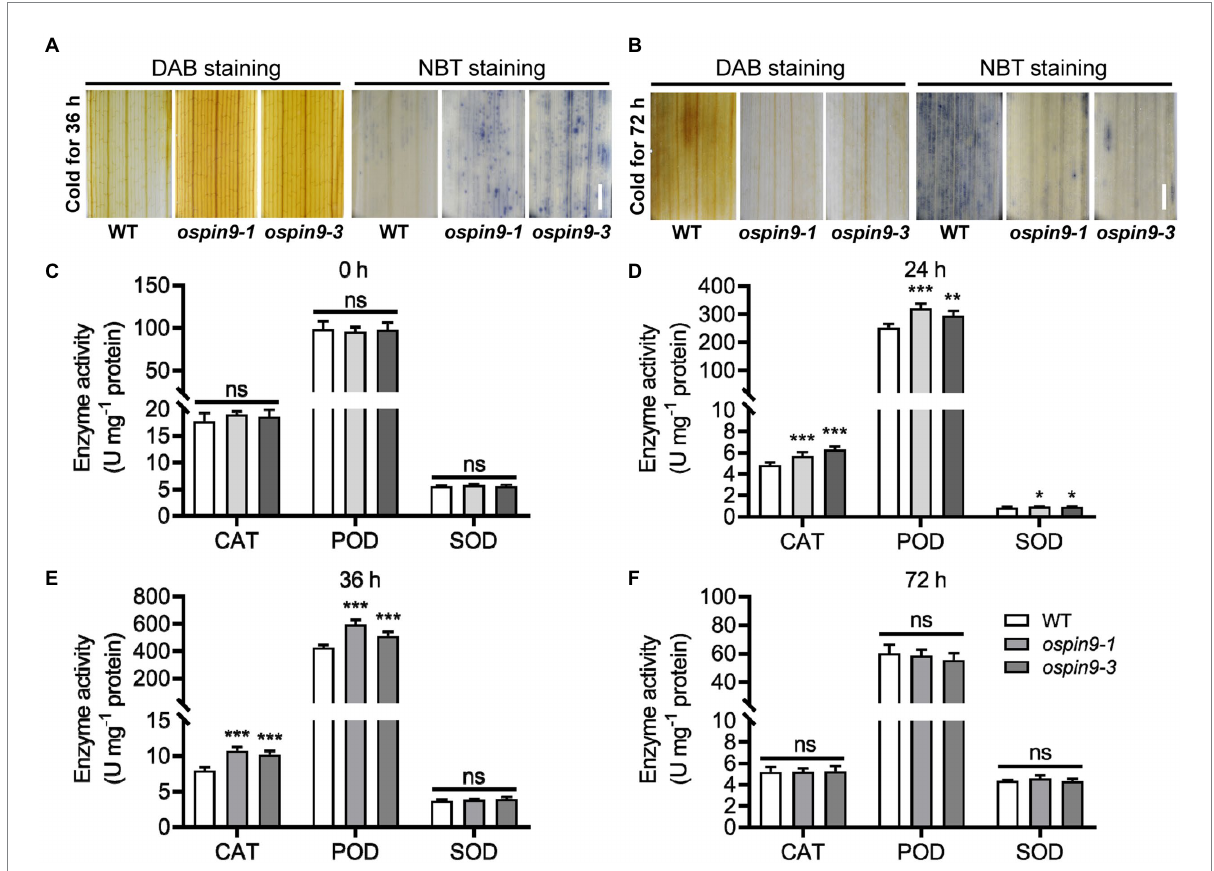
FIGURE 7 ROS production and scavenging in WT and ospin9 mutants during chilling stress. (A) ROS accumulation in WT and ospin9 mutants was detected at 36 h with NBT and DAB staining. Bar = 1 mm. (B) DAB and NBT staining for WT and ospin9 mutants after chilling treatment for 72 h. Bar = 1 mm. (C–F) Antioxidant enzyme activities analysis after chilling for 0, 24, 36, and 72 h in WT and ospin9 mutants. Values were means ± standard deviation (SD; n = 6). Data were analyzed by ANOVA and Tukey’s tests at p < 0.05 significant level.